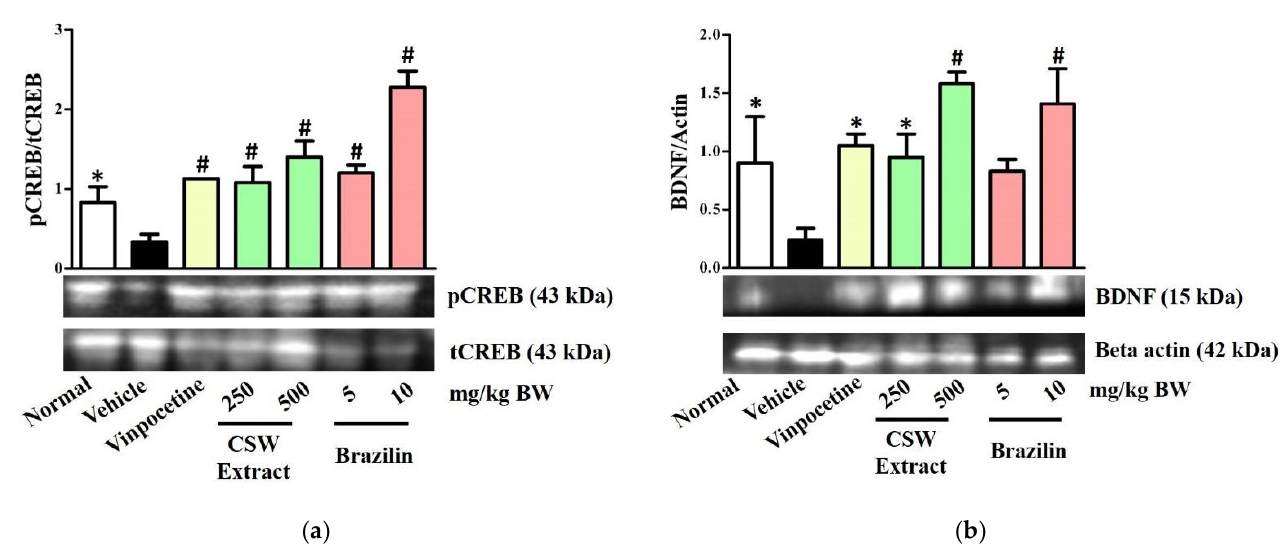
Figure 5. Effect of CSW ethanolic extract and brazilin on the protein expression level of ( a ) pCREB and ( b ) BDNF in the hippocampus. Data are presented as mean ± SEM ( n = 3) and were analyzed using a one-way ANOVA followed by the LSD post-hoc test. * p < 0.05 and # p < 0.01 indicate significant differences compared to the vehicle (untreated) group.